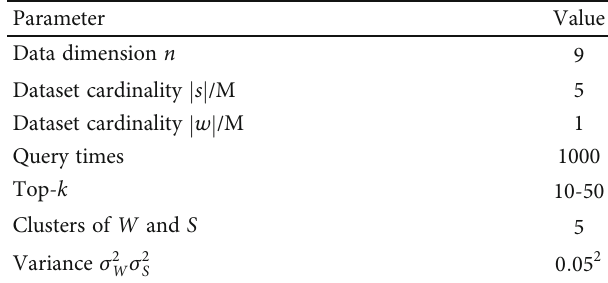
Table 1: Parameters in the experiment.